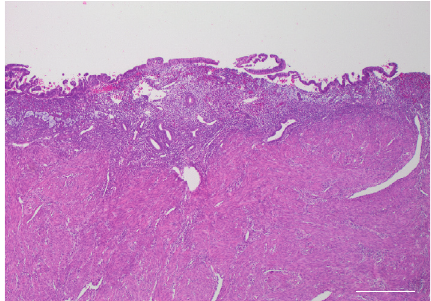
Figure 1: Peritoneal biopsies demonstrating involvement by low- grade appendiceal mucinous neoplasm (i.e., “low-grade mucinous carcinoma peritonei”); 20x, H&E, and scale bar = 100 micrometers.